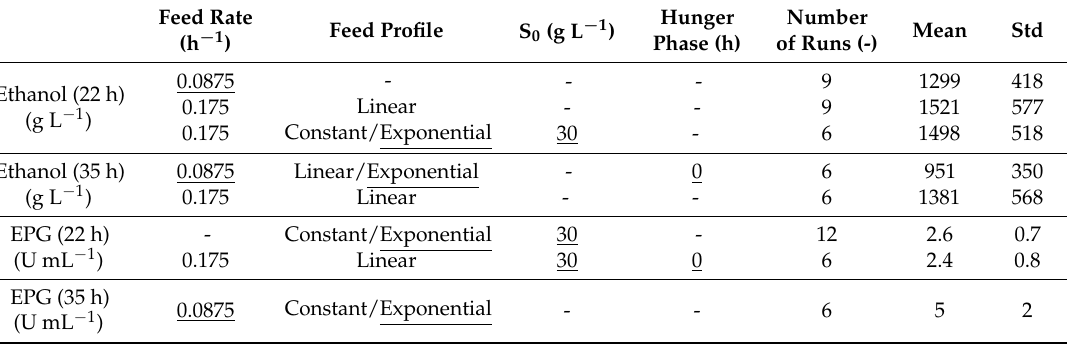
Table 3. Optimal conditions regarding the feed rate and profile, the initial substrate concentration S 0 and the presence of a hunger phase identified by decision tree analysis for high volumetric EPG activity and low ethanol production. Each row in the table corresponds to an optimal combination of process conditions for the considered target variable. The total number of runs performed under these conditions as well as the mean and standard deviation of the ethanol concentration and volumetric EPG activity is given regarding those runs. The symbol ‘-’ indicates that any value of this variable is acceptable. Conditions which lead to an optimal result regarding both ethanol concentration and volumetric EPG activity at both time points are